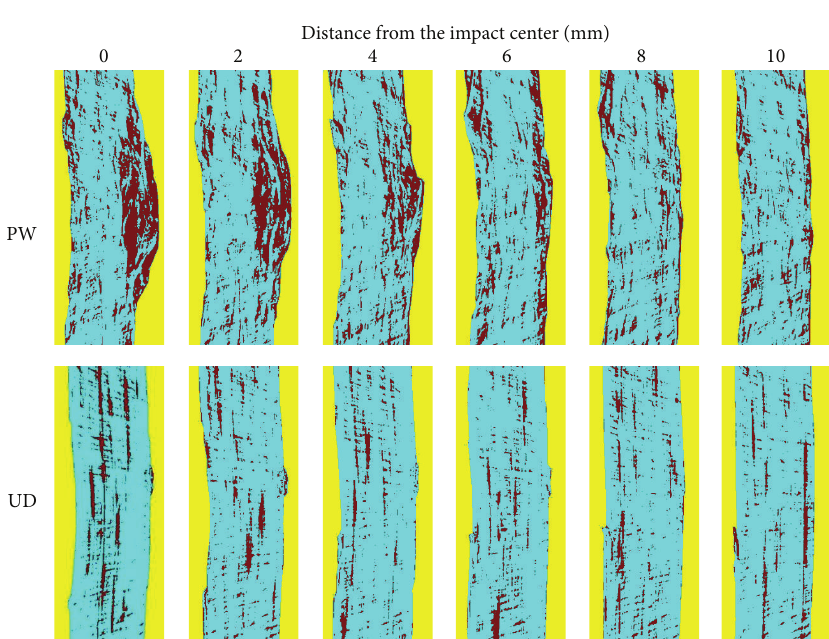
Figure 12: XMT left view histogram of the impacted PW and UD